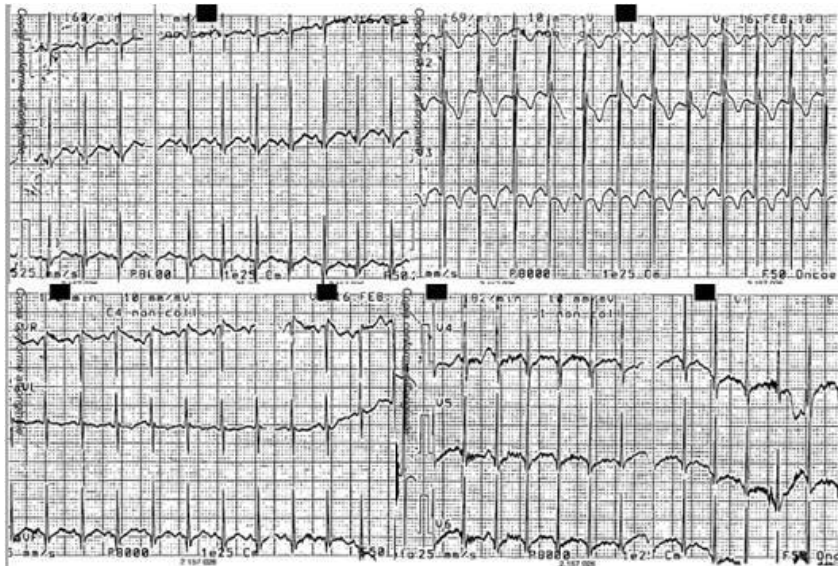
Figure 2. Electrocardiogram after cardiac resuscitation.